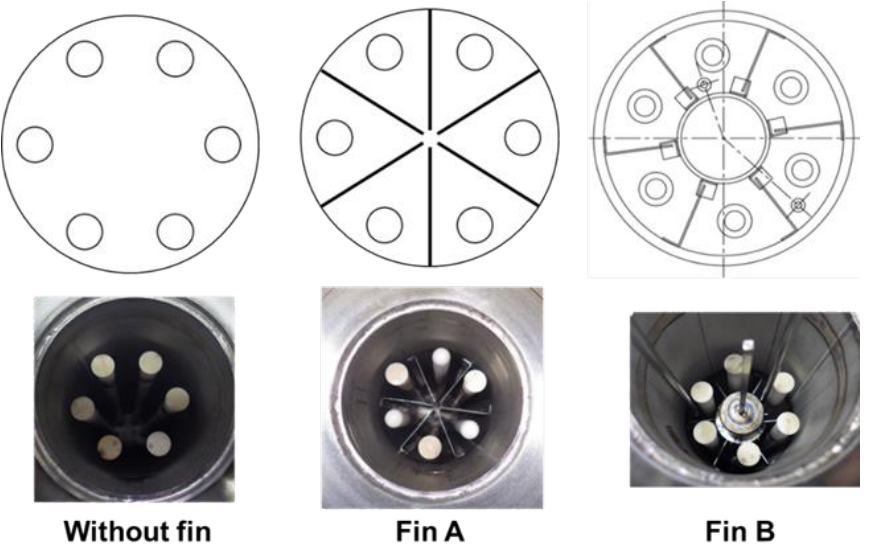
Figure 6. Structures of heat conductive fins to improve heat transfer from the heat medium to the catalyst layer.